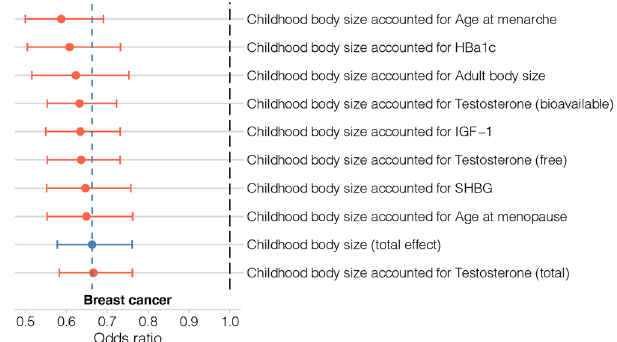
size direct estimates accounted for selected mediators. The plot shows the odds of breast cancer per SD change in the direct effect (red) of childhood body size accounted for mediators. The total effect (blue) (OR: 0.66 [0.57: 0.76]) and direct effect (i.e., accounted for adult body size, OR: 0.62 [0.51: 0.75]) estimates of childhood body size on breast cancer risk were re-calculated (Supplementary Data 6) from the original study [15] (using the thresholds de fi ned in the Methods to match other MR analysis in this study), included here for comparison. The vertical blue line shows the value of the total childhood body size effect point estimate (0.66) relative to the direct estimates. Bars indicate 95% con fi dence intervals around the point estimates from IVW-MVMR. The estimated values and the numbers of genetic variants included in the analyses are given in Supplementary Data 5. The details about the datasets are given in Table